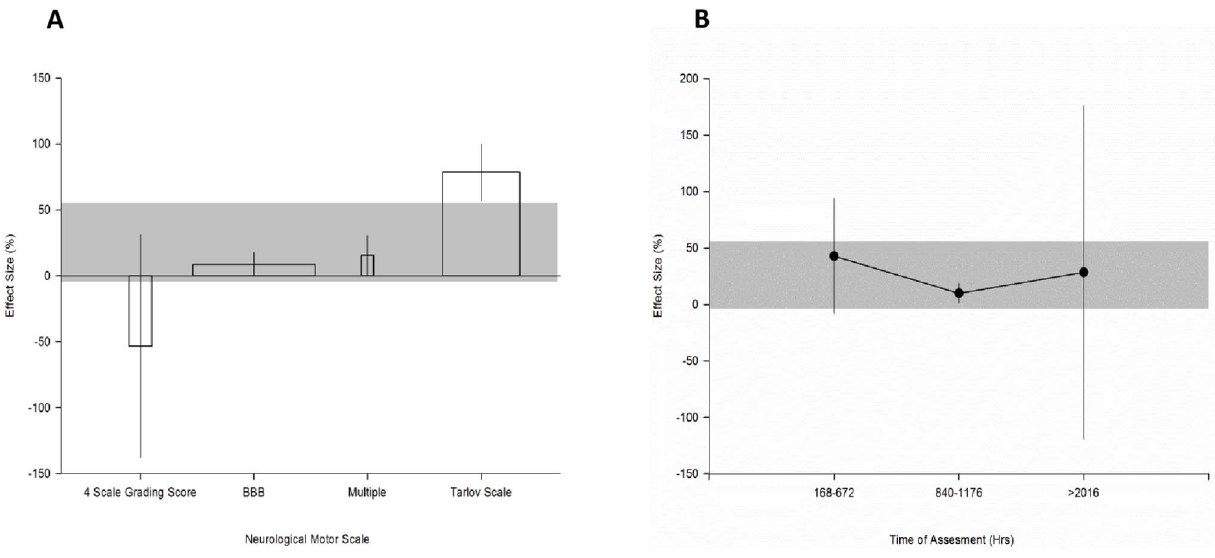
Figure 8. Outcome specific parameters of regional hypothermia experiments. Effect of ( A ) neurobehavioural scale and, ( B ) time of assessment on the reported effect size of experiments employing regional hypothermia. The shaded gray bar represents the 95% confidence limits of the global estimate. The vertical error bars represent the 95% confidence intervals for the individual estimates. The width of each bar reflects the log of the number of animals contributing to that comparison. Each stratification accounts for a significant proportion of the heterogeneity observed between studies.